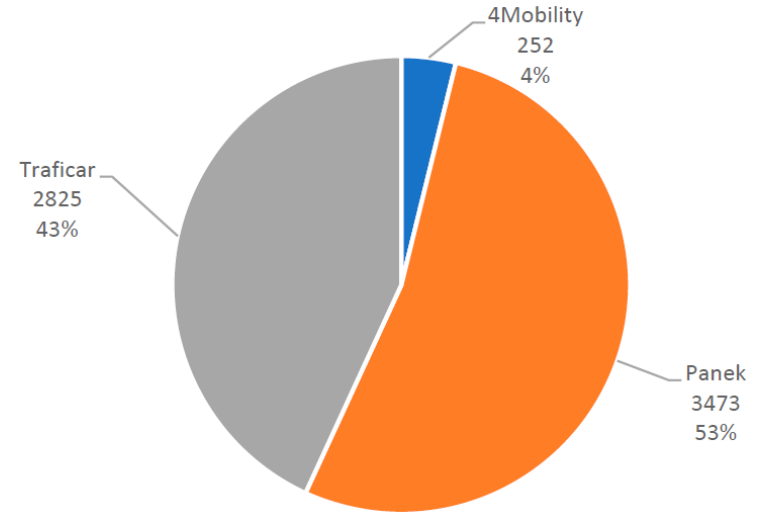
Figure 3. The number of collected comments by the car-sharing operator.